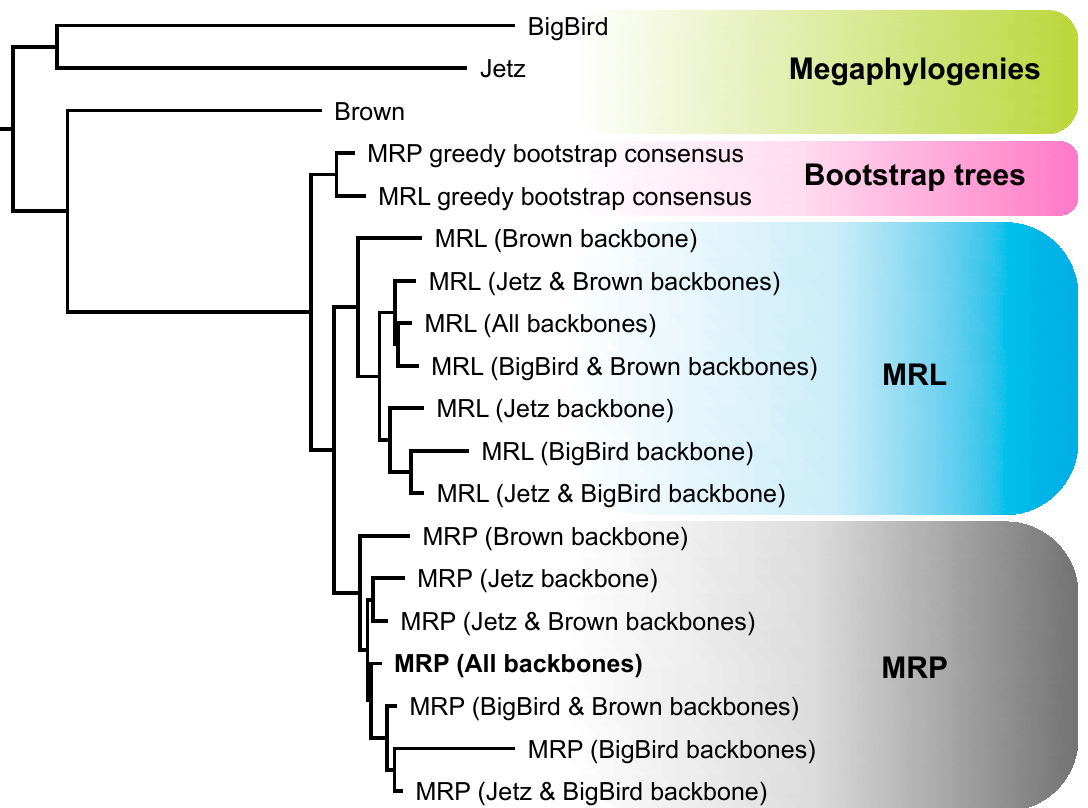
Figure 4. Clustering diagram emphasizing the similarities and differences among supertrees and backbone megaphylogenies. This “tree-of-trees” was generated by clustering Robinson-Foulds distances [98] among trees by neighbor joining. The tree-of-trees emphasizes the clustering of supertrees by method (i.e., there are three major groups: matrix representation with parsimony [MRP], matrix representation with likelihood [MRL], and extended majority rule consensus of bootstrap supertrees) and the distance between the supertrees and the backbone trees. The MRP tree for all backbones is emphasized because much of our discussion uses this tree; all trees are available in Supplementary Material.